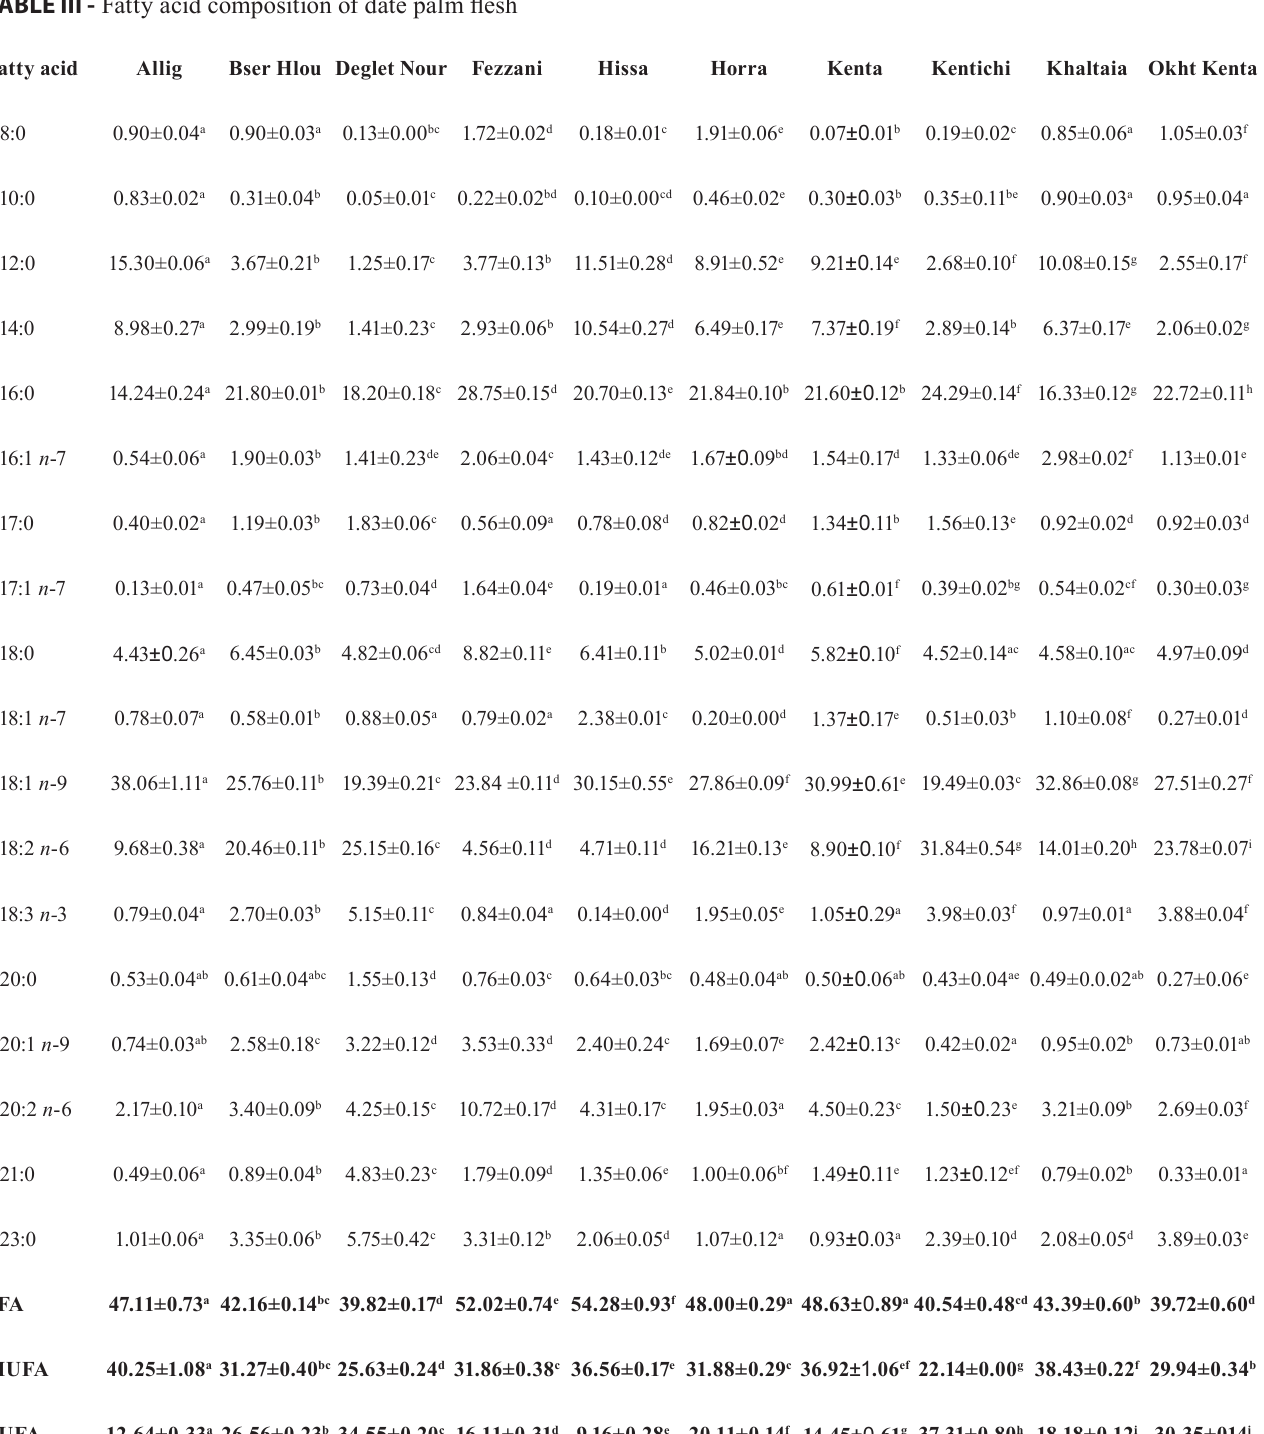
TABLE III - Fatty acid composition of date palm flesh